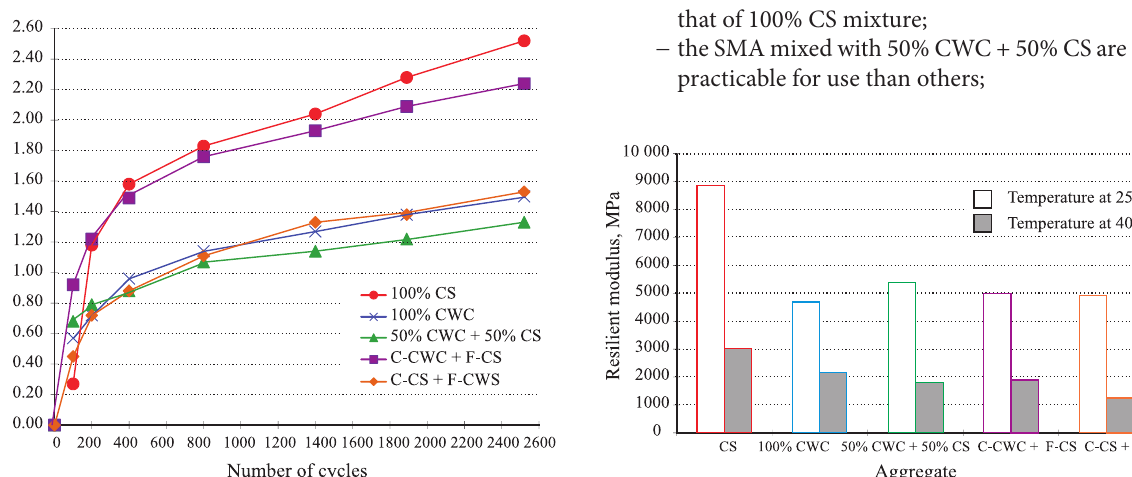
Fig. 1. Rutting test results at 25 °C